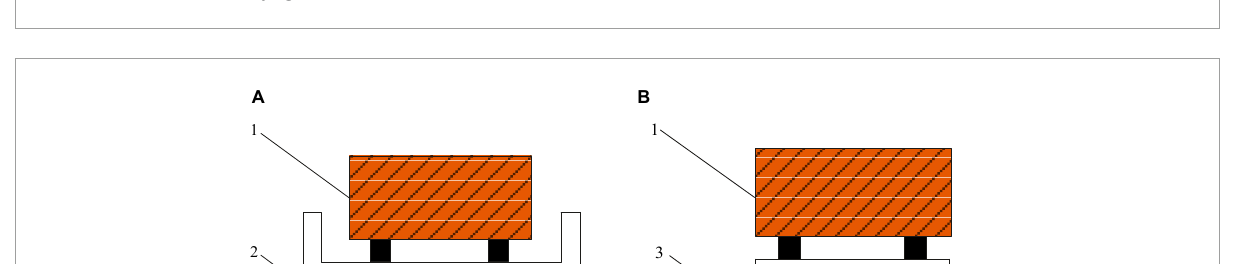
FIGURE1 Modern standardized facility agricultural corridor environment.